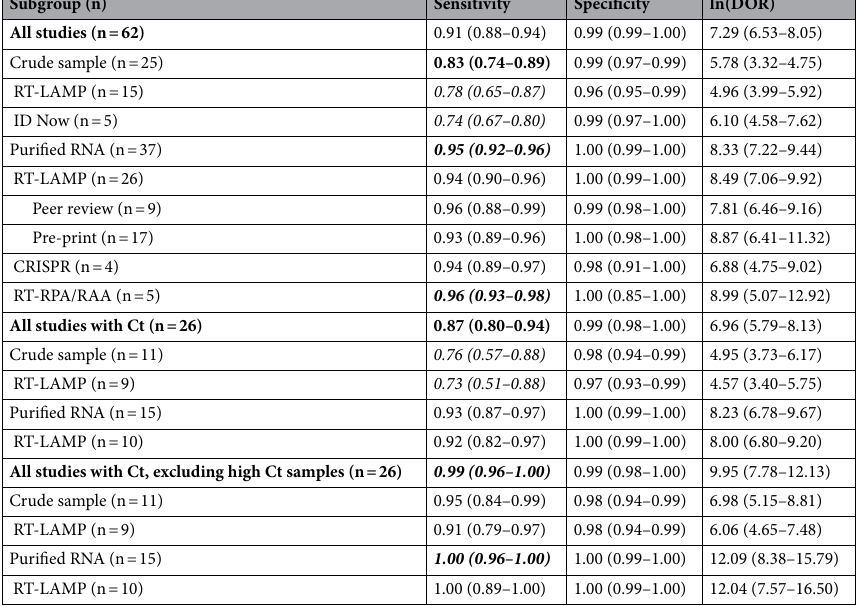
Table 1. Summary of sensitivity, specificity and DOR. The numbers in each cell show estimated pooled sensitivity, specificity and ln(DOR). The numbers in parentheses are 95% confidence intervals. For the sensitivity column, italics cells indicate expected pooled sensitivity values at 70–80%; bold, expected pooled sensitivity values at 80–90%; bold-italic, lower band for 95% confidence interval of pooled sensitivity values above